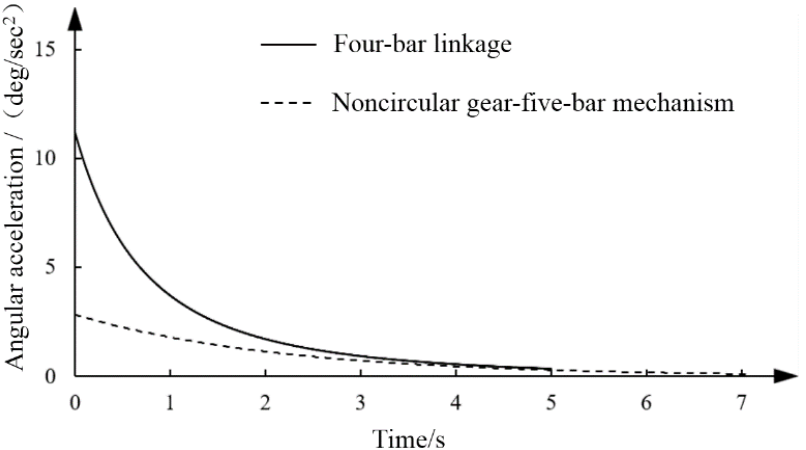
Figure 22. Comparison of angular acceleration between four-bar linkage and noncircular gear-five-bar mechanism.